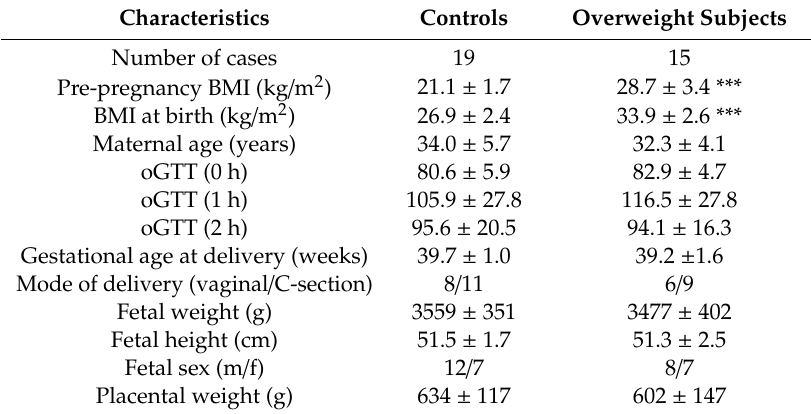
Table 1. Characteristics of the fpEC